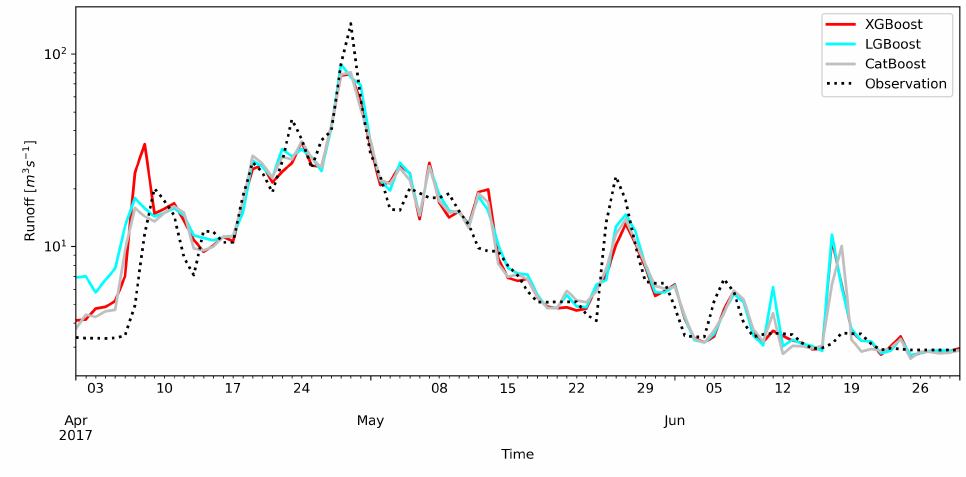
Figure 12. Daily runoff forecast for Wadowice on Skawa River—problem with forecast in